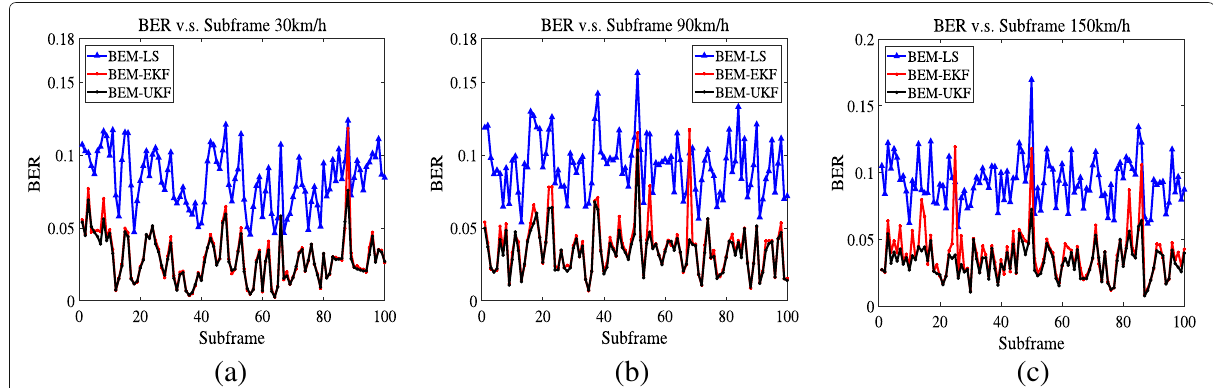
Fig. 6 BER for channel estimation methods in different velocities where the SNR = 10 dB. BERs change in continuous 100 subframes with different velocities. The means of BER of BEM-EKF and BEM-UKF are nearly one third of BEM-LS, and the variance of BEM-EKF and BEM-UKF are also much lower than traditional BEM-LS a lot in all the velocities. It is obvious that the BEM-EKF and BEM-UKF could improve the stability and reliability of CPS